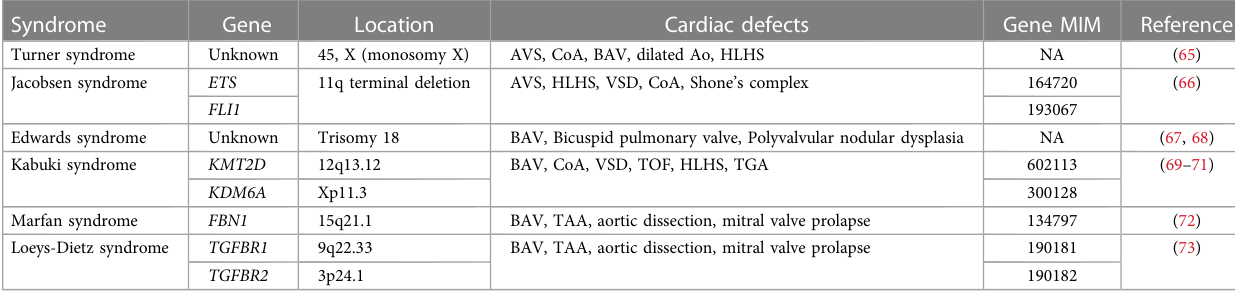
TABLE 1 Genetic syndromes associated with congenital aortic valve disease.